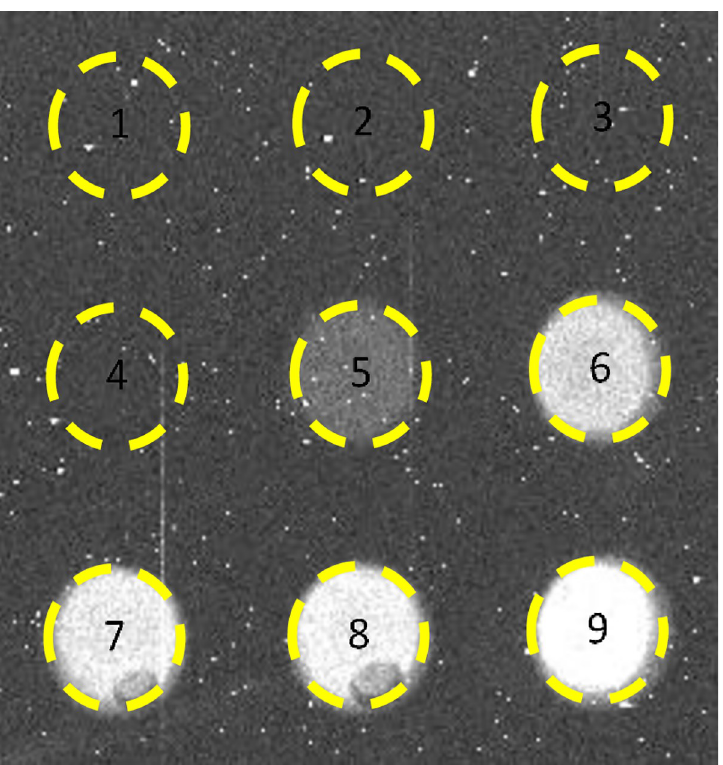
Fig 2. Image of an example custom bioluminescence assay plate that shows an inverse dose - response relationship between Nhe concentration (wells 1–9 highest to lowest) and increasing levels of bioluminescence intensity from the reaction mixture in the custom assay plate